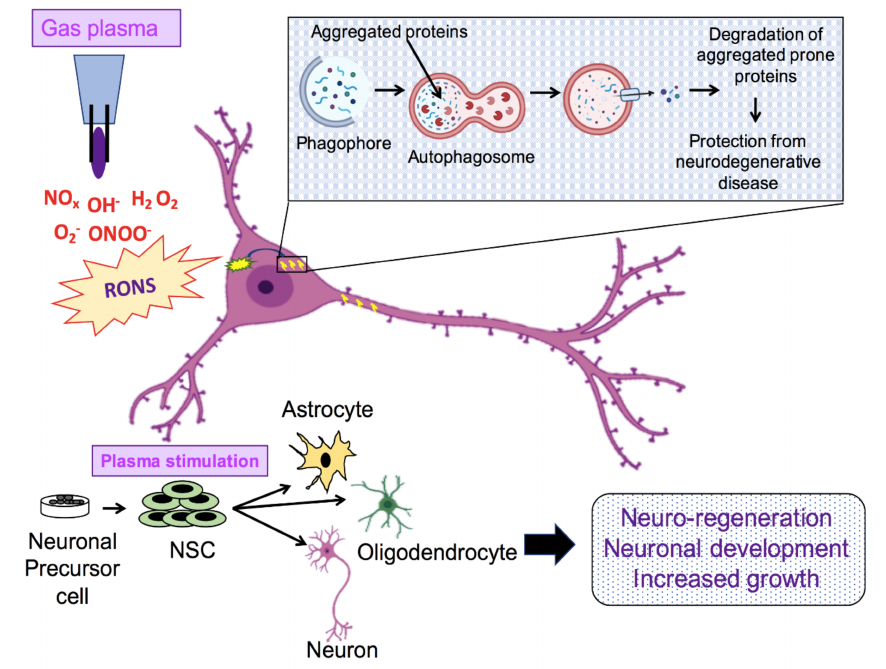
Figure 5. Possible mechanism of action of non-thermal plasma over neuronal di ff erentiation and neurodegenerative